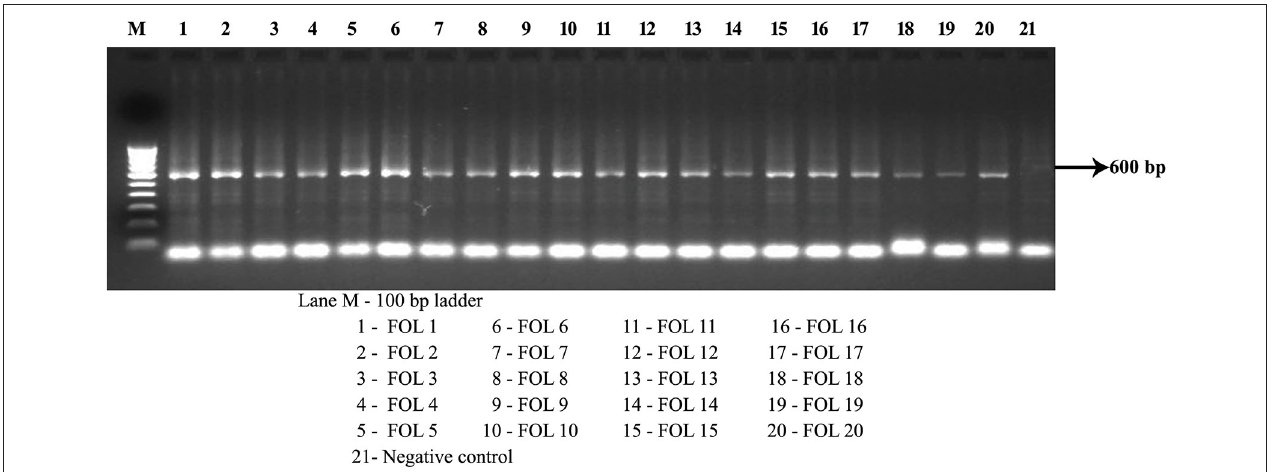
FIGURE 3 | Protein profiling of F. oxysporum f.sp. lycopersici isolates by SDS-PAGE.